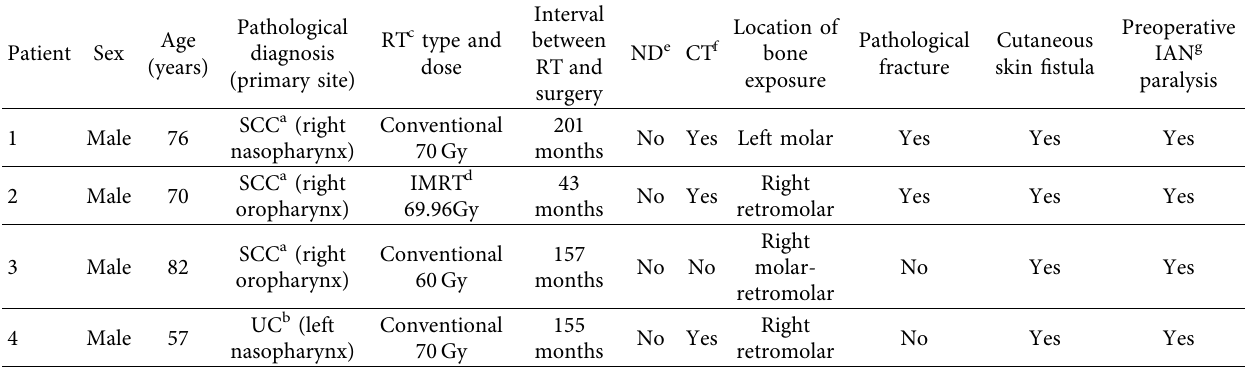
Table 1: Clinical characteristics of patients with advanced mandibular